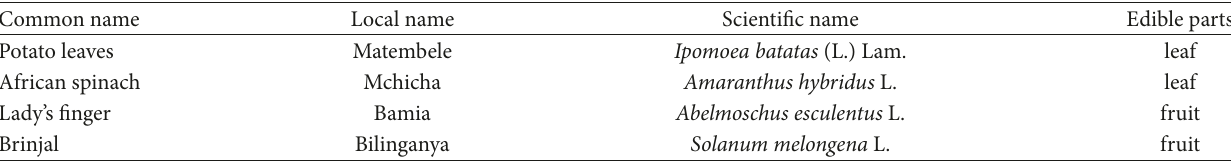
Table 1: Description of the collected and analyzed vegetable